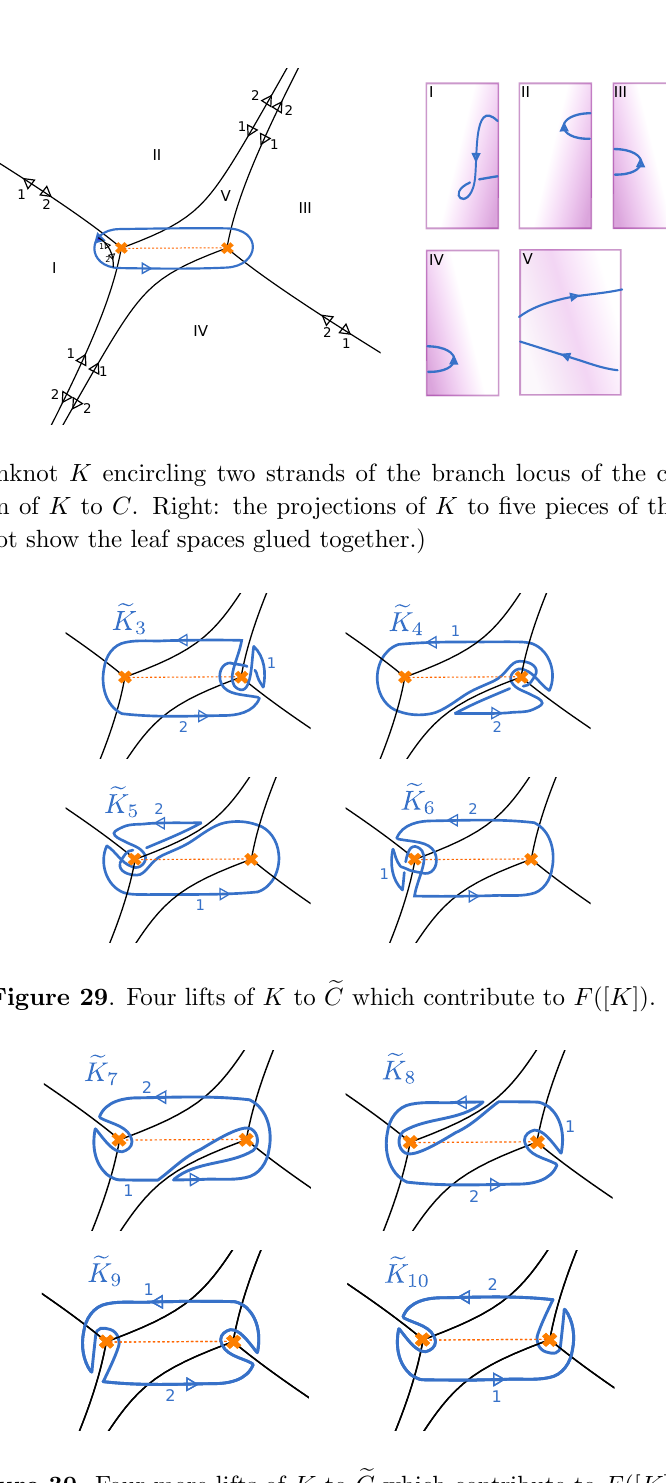
Figure 30 . Four more lifts of K to e C which contribute to F ([ K